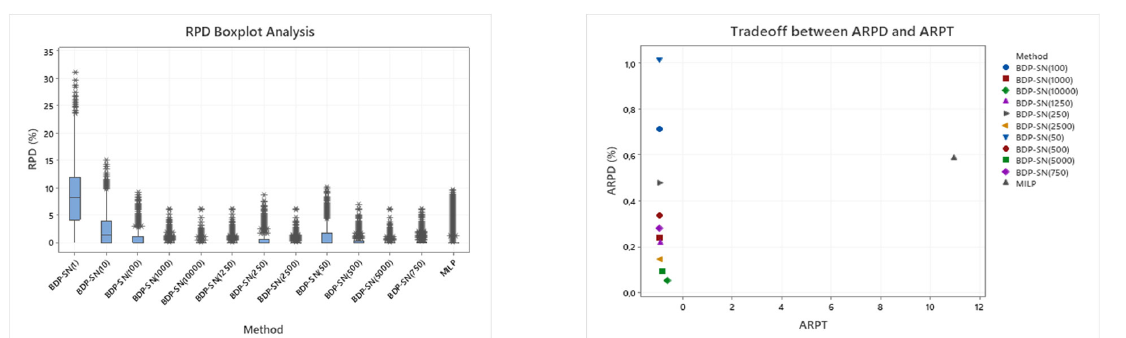
Fig. 11. Tradeoff with respect to ARPD and ARPT for the second experimental